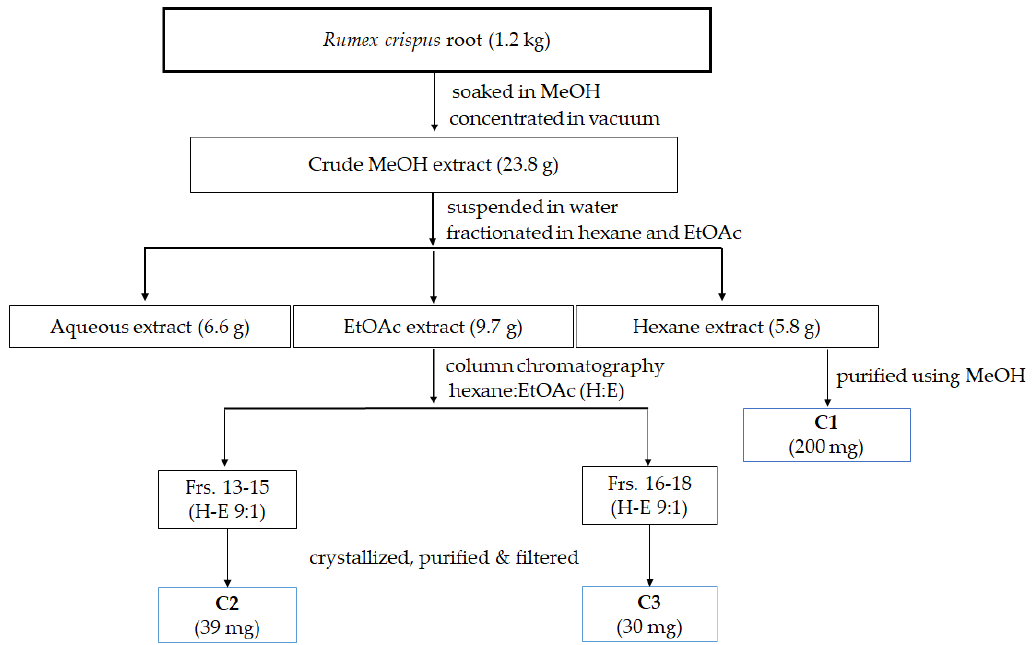
Figure 1. Isolation and purification of bioactive compounds from Rumex crispus root.